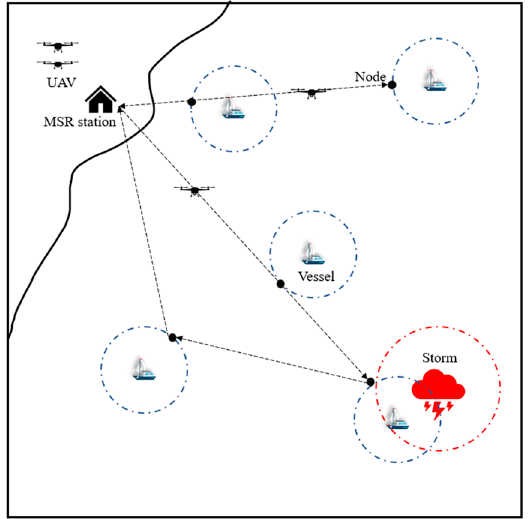
Figure 1. An example of multi-objective MSR problem under severe weather.